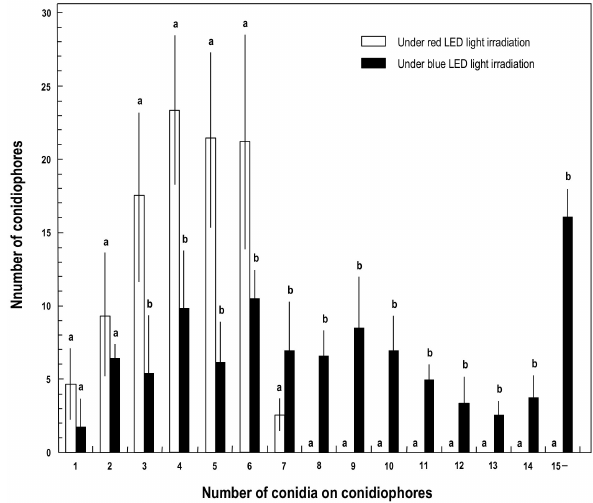
Figure 2. Frequency distribution of conidiophores with different numbers of conidia under red and blue LED irradiation. Conidiophores were counted in 12-day-old KMP-6N colonies, incubated for 10 days under growth chamber conditions and then for 2 days under red or blue LED irradiation. The numbers in the axis mean the number of conidia piled in chains on conidiophores. KMP-6N did not pile more than eight conidia in chains on conidiophores under red LED light irradiation while more were piled under blue LED light irradiation. Data are means ± standard deviations (SDs) of five replicates. Different letters (a and b) indicate significant differences ( p < 0.05, Tukey’s test).